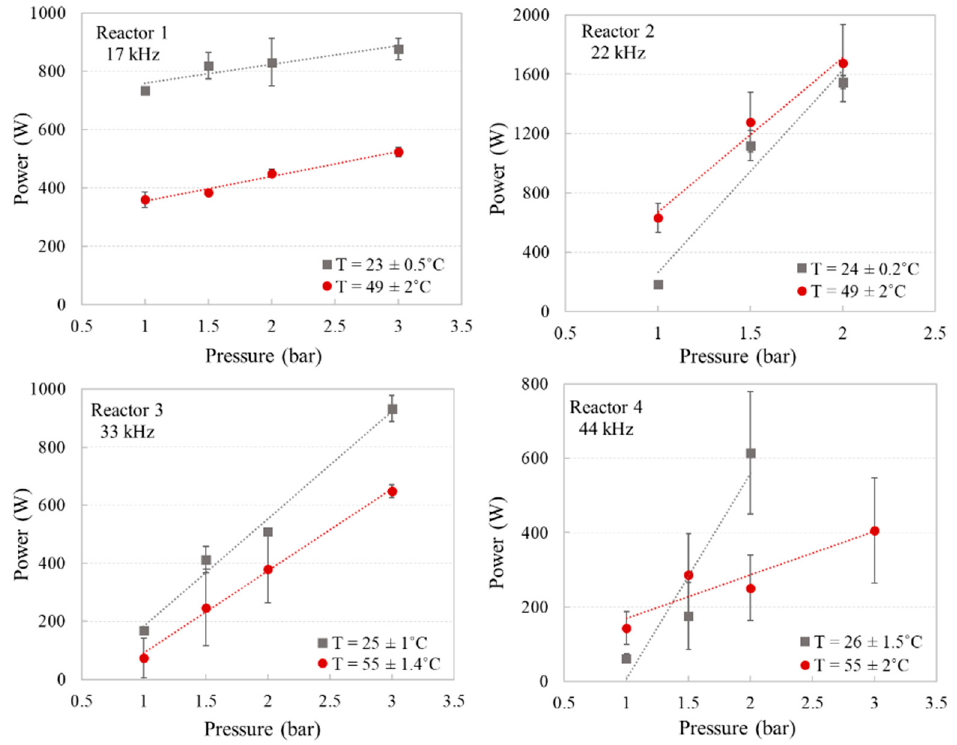
Figure 6. The threshold power of the ultrasonic transducer, leading to cavitation, in dependance on the external pressure for room temperature and 50 °C, subject to an increase in power to 100% in 100 s (Figure 4a).